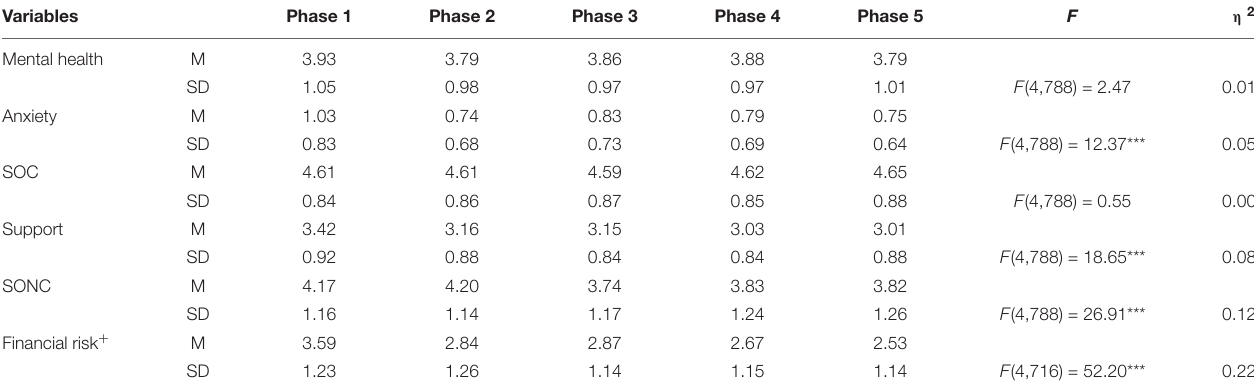
TABLE 5 | Means and SD for each variable of the research, separately for each phase ( n = 198).